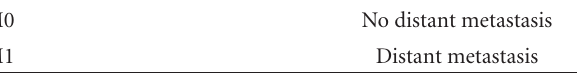
Table 4: Distant metastasis (M).